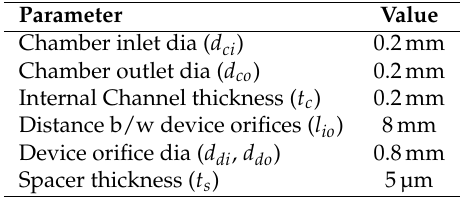
Table A2. Microchannel and Spacer Design Parameters.